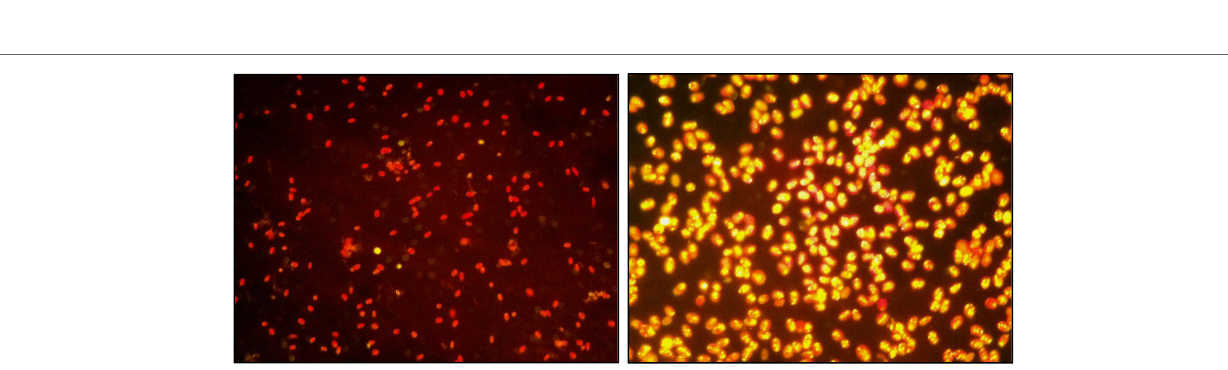
FigUre 3 | Two nile red-stained samples of Tetraselmis sp . M8 culture (40 × magnification) before (left) and after nutrient deprivation stress at the time of harvesting (right).